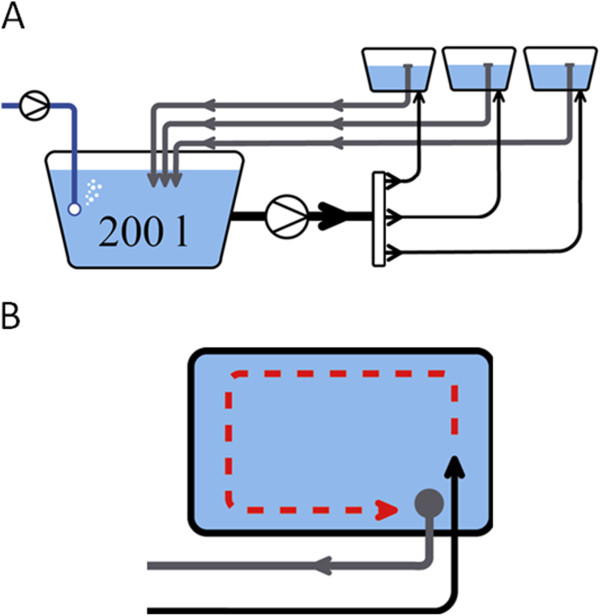
Hydroponic system. A.  The utilised hydroponic system included an accumulation tank for 200 l of nutrient solution that was connected to three boxes for plant cultivation. B. The nutrient media circulated permanently between the boxes and the tank, ensuring that within and between boxes all plants were exposed to the same nutrient composition.